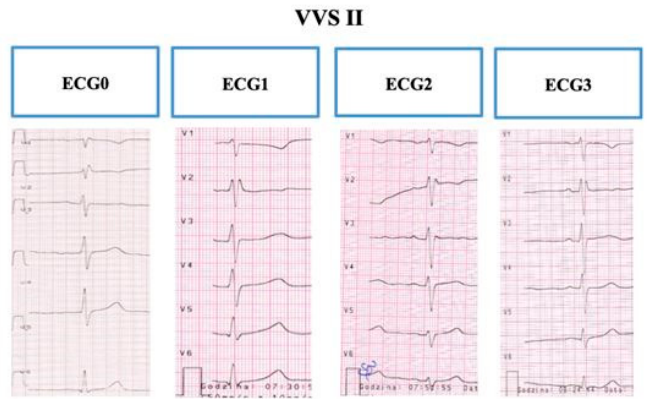
Figure 1. The sample electrocardiogram of a child with vasovagal syncope with variable T-wave morphology (VVSI) recorded on admission to the ward and in the three phases of the tilt test: two-humid T-waves are visible in a 2-phase electrocardiogram (after standing) in V4-V6 leads. Source: the medical documentation of a child with children with vasovagal syncope, hospitalized at the Children’s Cardiology Clinic.